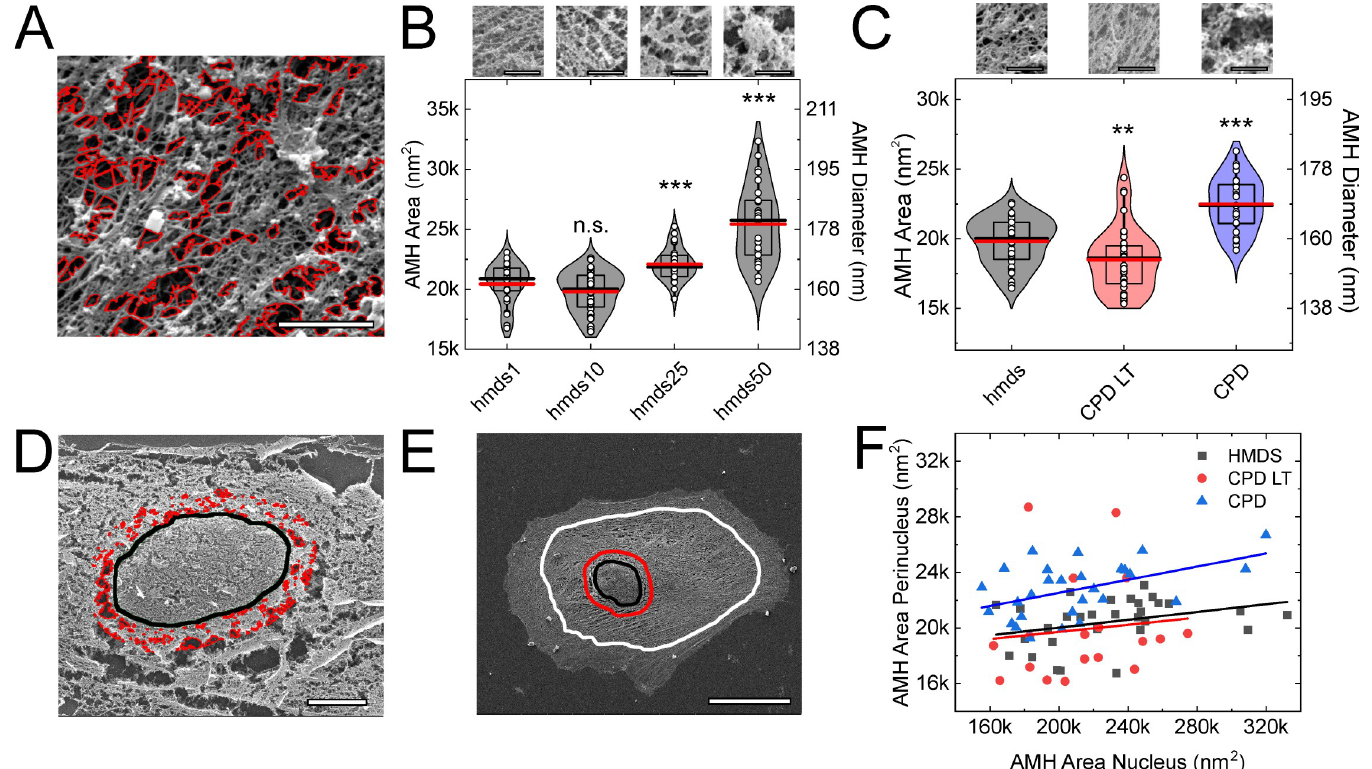
Fig 2. Artifactual mesh hole analysis. ( A ) Representative image following HMDS10 drying and vectorial tracing (red) of artifactual mesh holes (magnification, 80k × ). ( B , C ) Quantification of the artifactual mesh hole sizes according to the different HMDS protocols (Table 1) (B), and for HMDS10 (hmds) in comparison with CPD-LT and CPD as shown in Fig 2 (C). �� , p < 0.01; ��� , p < 0.001; n.s., non-significant; each data set was compared to hmds1 (B) or hmds (C) using t-tests. ANOVA tests: p = 1.88 � 10 − 21 (B), p = 5.24 � 10 − 8 (C). Scale bars images (B, C): 100 nm. ( D , E ) Representative images following CPD showing the vectorial tracing of the artifactual mesh holes (red) within the 2- μ m band around the nucleus edge (black line) (D; magnification, 10k × ), and the definition of the perinucleus region, shown between the red and white lines (E; magnification, 5k × ). (A, D, E) Scales bars: 1 μ m (A); 5 μ m (D); 10 μ m (E). ( F ) Correlation between the artifactual mesh hole areas for the perinucleus and the 2- μ m nuclear band following the three SEM preparation protocols (as indicated). AMH, artifactual mesh hole. N = 30, 46, 30, 30 (B, from left to right); N = 46, 37, 28 (C, from left to right); N = 30, 20, 28 (F, hmds, CPD LT, CPD).